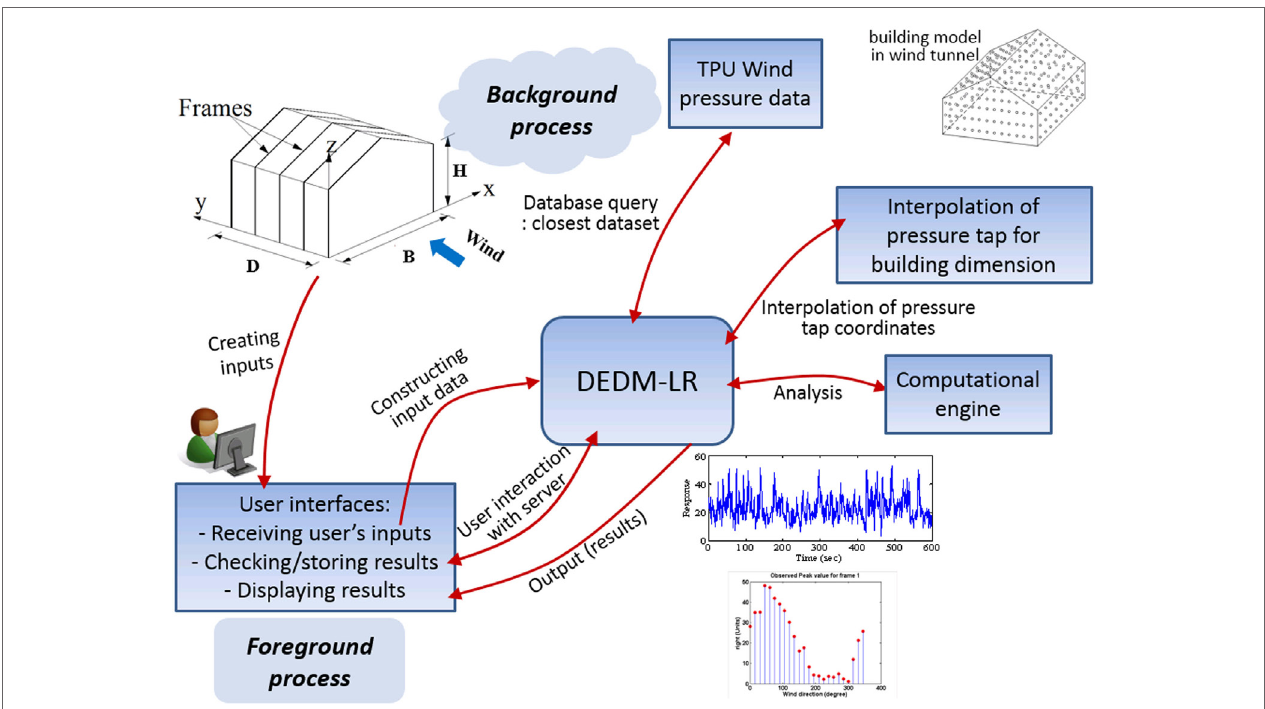
FigUre 6 | Schematic diagram of the Database-enabled design module for low-rise buildings